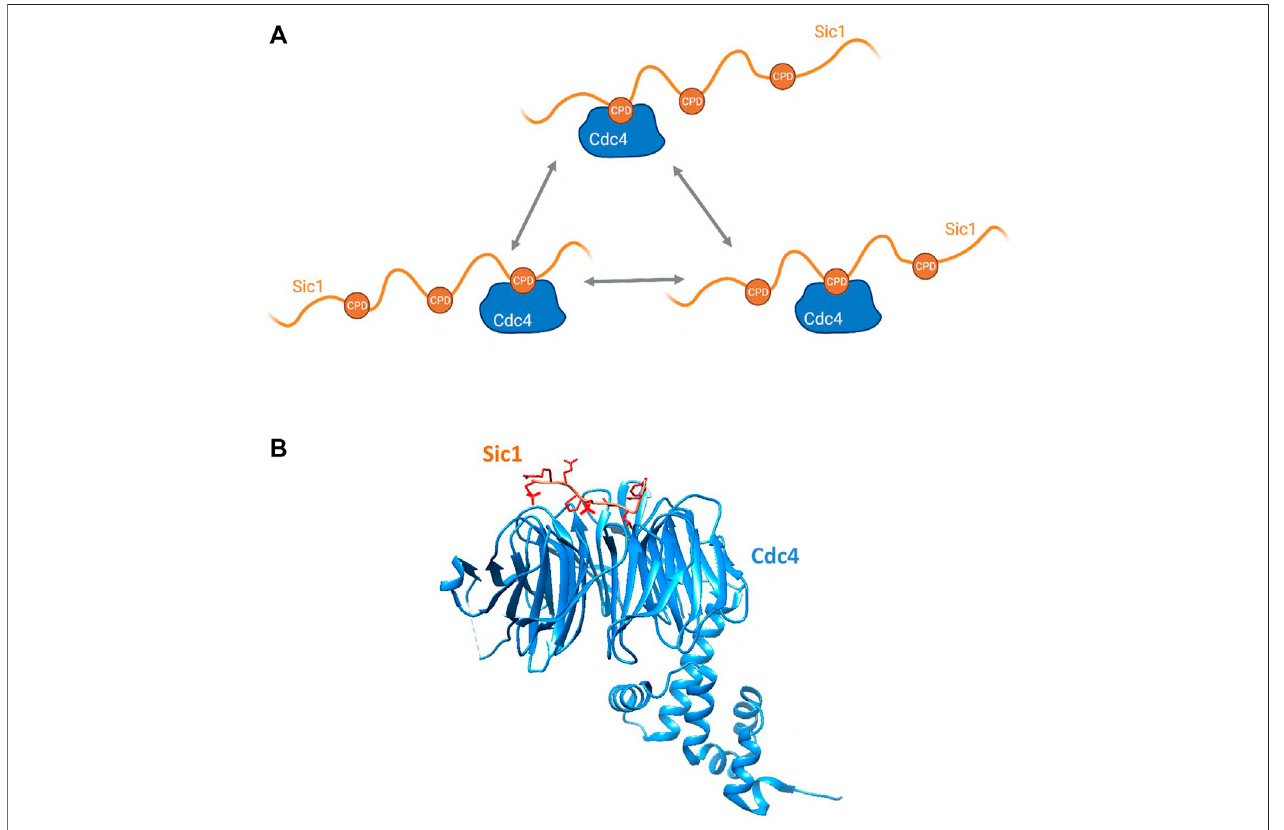
FIGURE 5 | (A) Schematic showing the allovalent mechanism of interaction between the multiple phosphodegrons of the intrinsically disordered Sic1 and the E3 Cdc4, described in Section 2.2.1 . Created with BioRender.com. (B) Structure of a Sic1 phosphodegron bound to Cdc4. Cdc4 is in blue and Sic1 in tan, with the phosphate groups shown in red. The model was made in Chimera (https://www.rbvi.ucsf.edu/chimera) using PDB:3V7D (Tang et al., 2012).